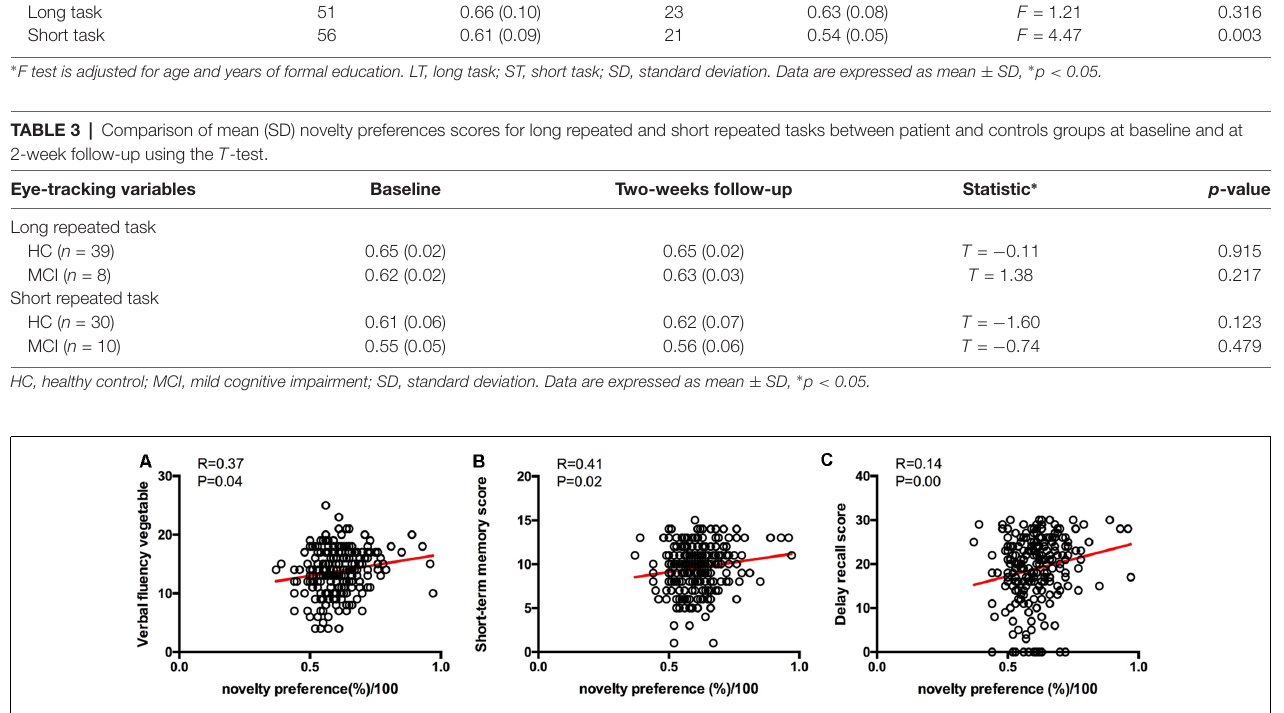
FIGURE 3 | Correlations between eye-tracking parameters and cognitive scores. Only significant findings are shown. (A) The novelty preference scores assessed by eye tracking system showed a positive correlation with the verbal fluency score. (B) The novelty preference scores assessed by eye tracking system showed a positive correlation with the short-term memory score. (C) The novelty preference scores assessed by eye tracking system showed a positive correlation with the delay recall score.